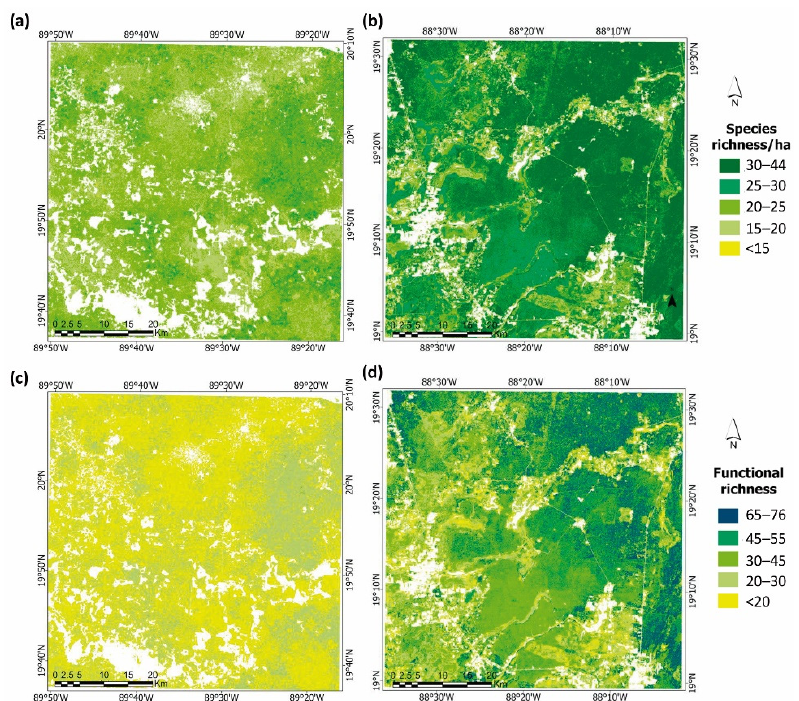
Figure 4. Maps of tree species richness and functional richness for the tropical semi-deciduous forest (( a ) and ( c ), respectively) and the tropical semi-evergreen forest (( b ) and ( d ), respectively). Blank areas correspond to non-forest cover (mostly cropland and human settlements).